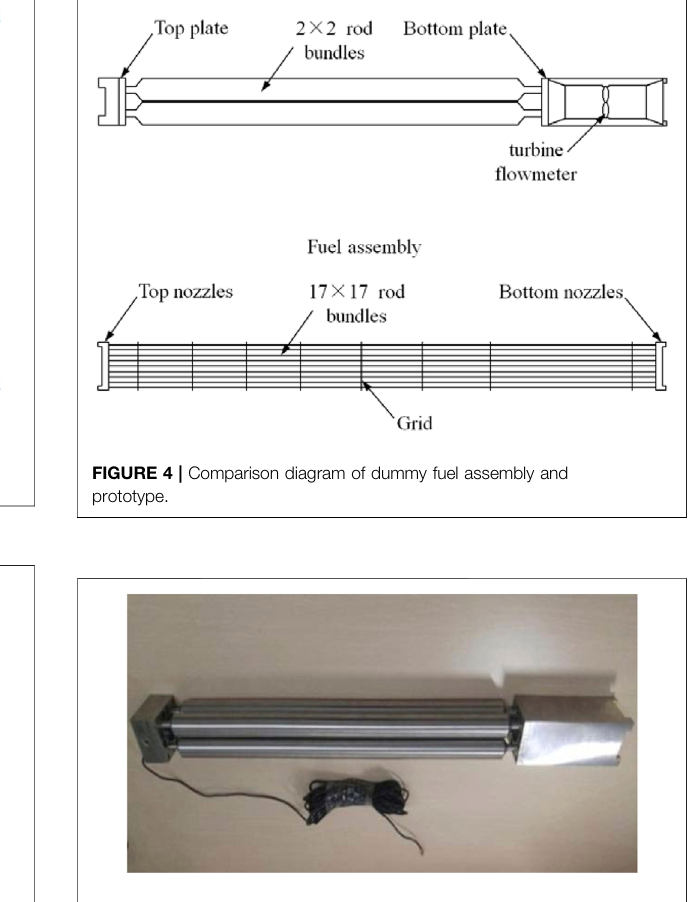
FIGURE 5 | Photograph of dummy fuel